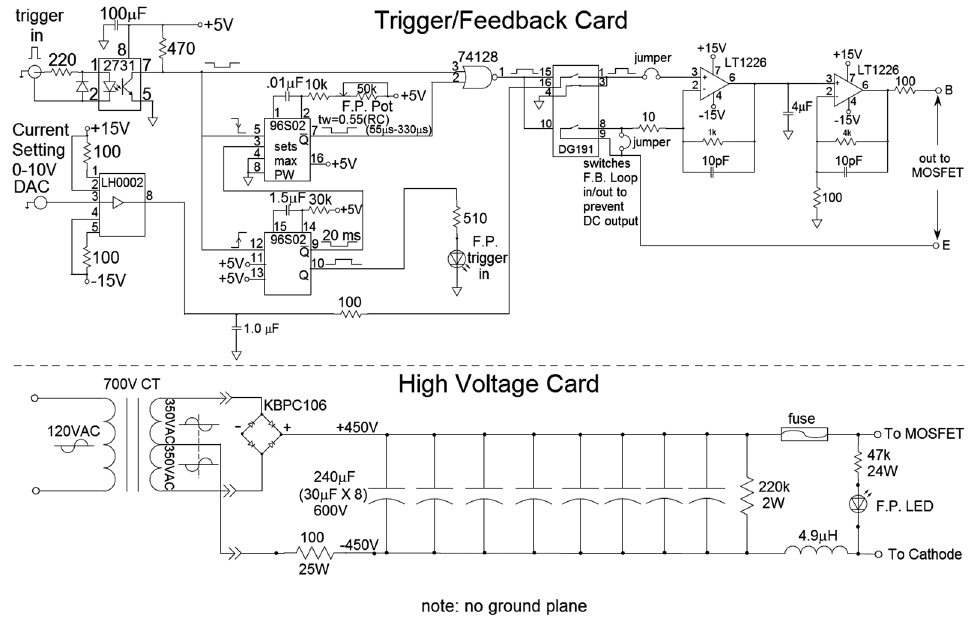
FIG. 11. Circuit diagram of the current-regulated arc modulator.